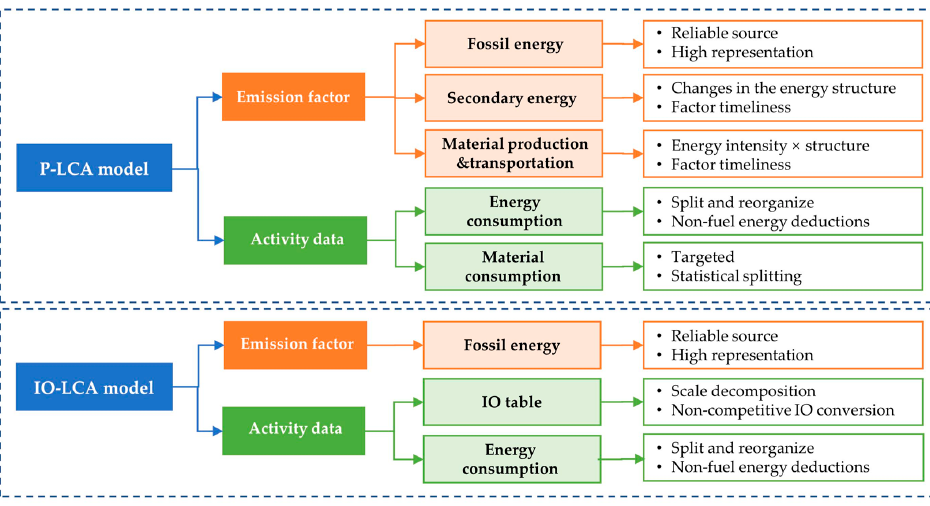
Figure 7. Basic datasets for embodied carbon emission accounting.